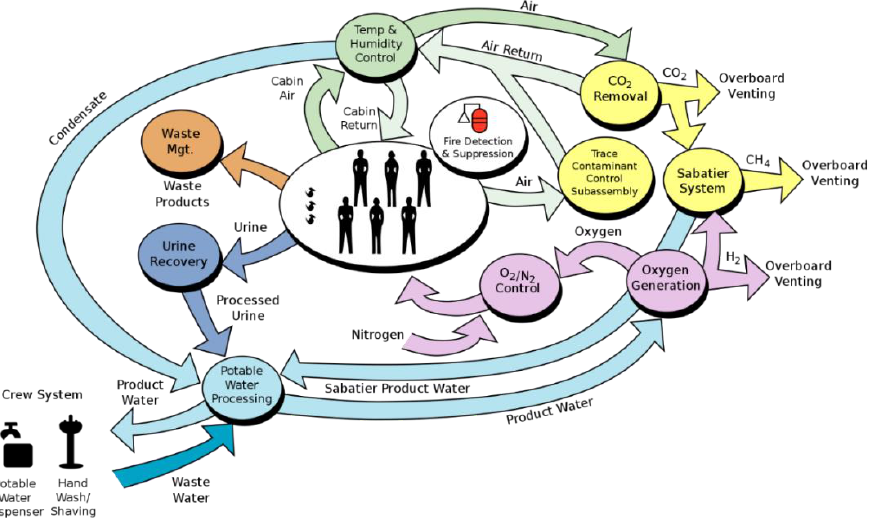
Figure 9. Environmental Control and Life Support Systems of the ISS [130]. Credit: NASA.